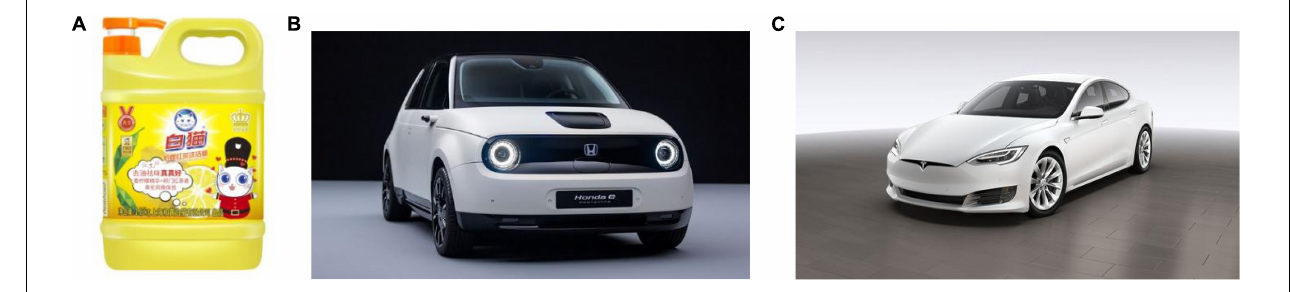
FIGURE 1 | Environmental detergent with cute cat anthropomorphic image (A) and new energy environmental vehicles’ front-face modeling with cute anthropomorphic elements (B) and cool anthropomorphic elements respectively (C)